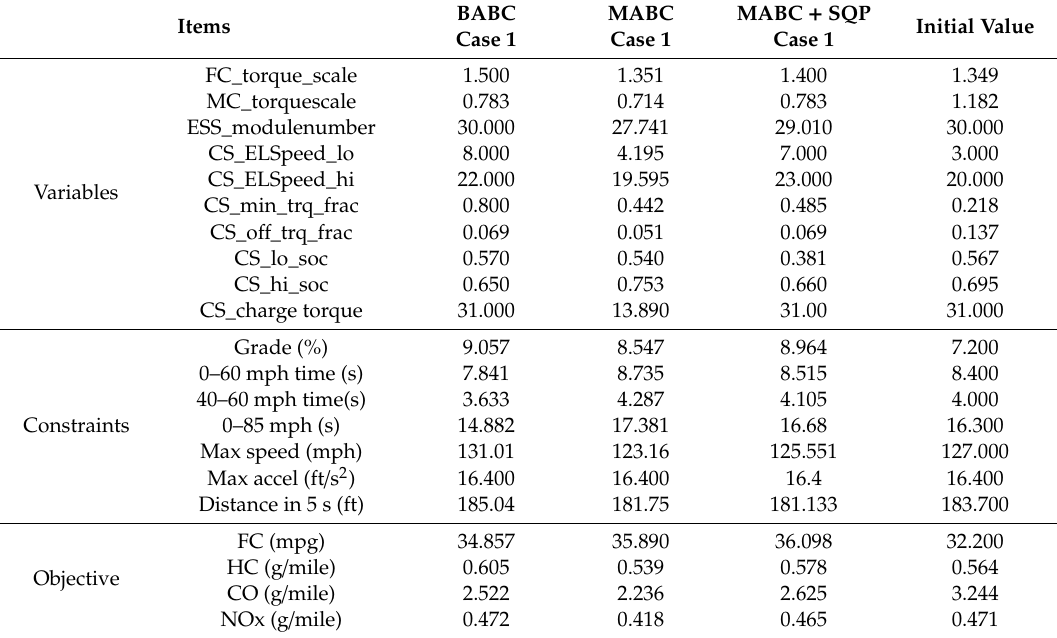
Table 7. Comparison of the FTP driving cycle for the BABC, MABC, and MABC + SQP